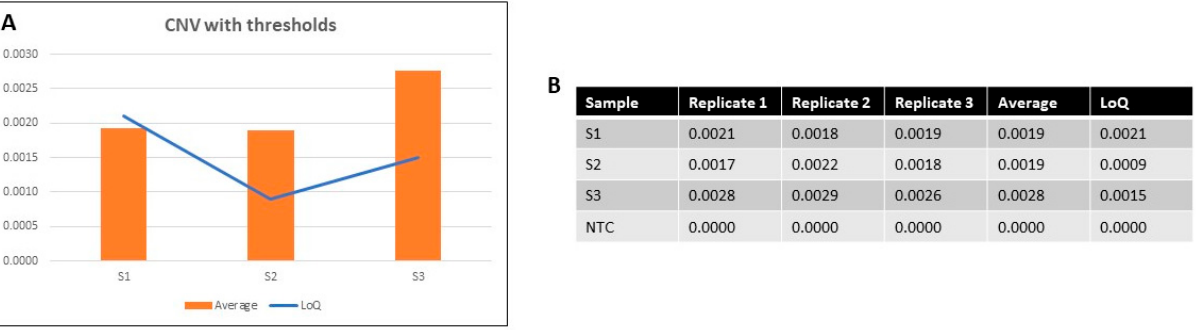
Figure 2. ( A ) Graph demonstrating the CNV average among triplicates per sample for S1, S2, and S3. The blue line shows the LoQ per sample, based on each patient’s pretreatment sample. S2 and S3 showed higher CNV averages than their corresponding LoQs, demonstrating CAR T persistence. ( B ) Table showing the detailed CNV numbers per replicate per sample, their averages, and the corresponding LoQs. NTC was run in parallel as a negative control.